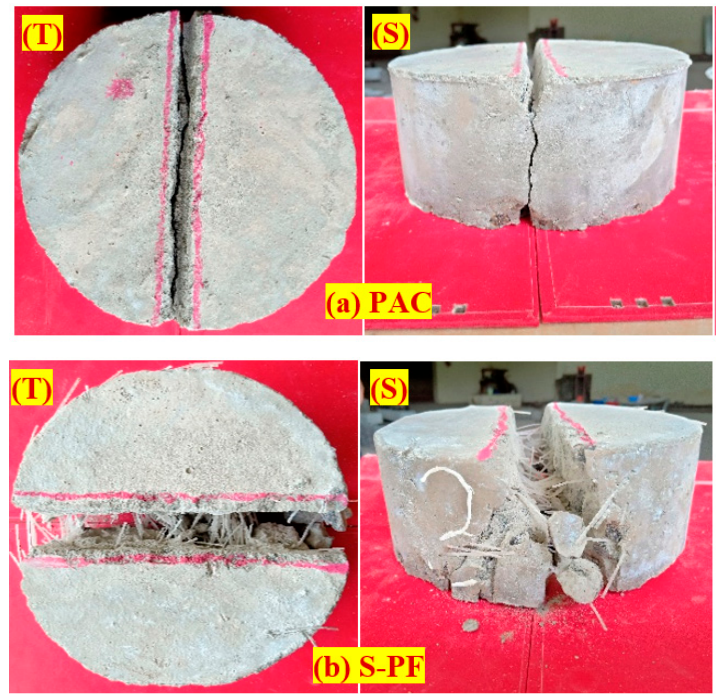
Figure 11. Failure of